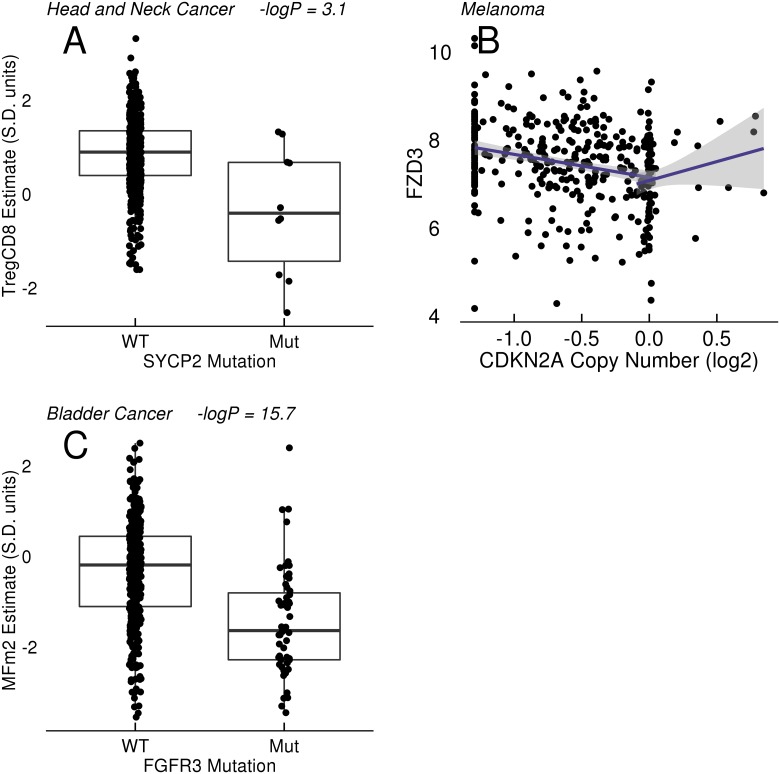
Association of SYCP2 and FGFR3 with immune estimates in tumors; correlation of chromosome 9p copy number (CDKN2A) with FZD3 RNA expression.A: Relationship between SYCP2 mutation and Treg—CD8 ratios in head and neck cancer. B: correlation of FZD3 (log2) RNA expression with CDKN2A copy number. C: Relationship between FGFR3 mutation and macrophage (MFm2) estimates in bladder cancer.